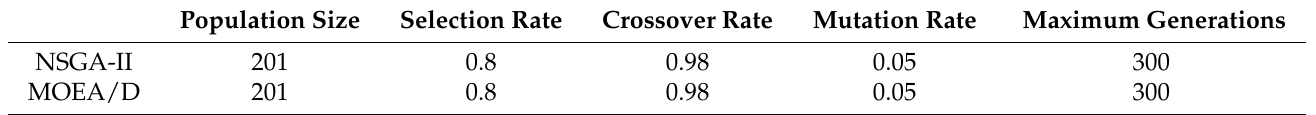
Table 2. The parameters used by NSGA-II and